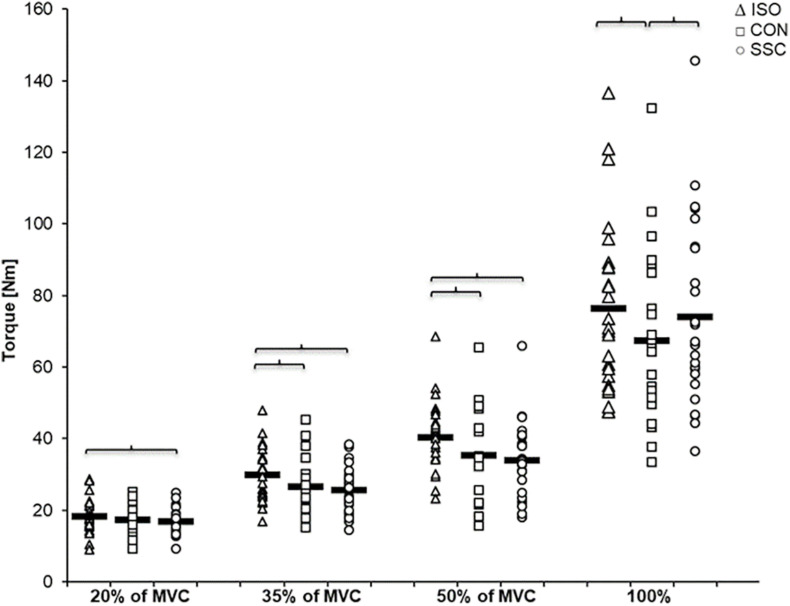
Mean (n = 27, thick horizonal line) (and mean of each individual subject) values of joint torque in the steady-state after the dynamic phase (T3). Triangles represent purely isometric torque at 20° knee flexion (ISO), squares represent concentric condition (CON), whereas circles represent stretch-shortening conditions (SSC). Braces indicate significant (p < 0.05) differences between the conditions.